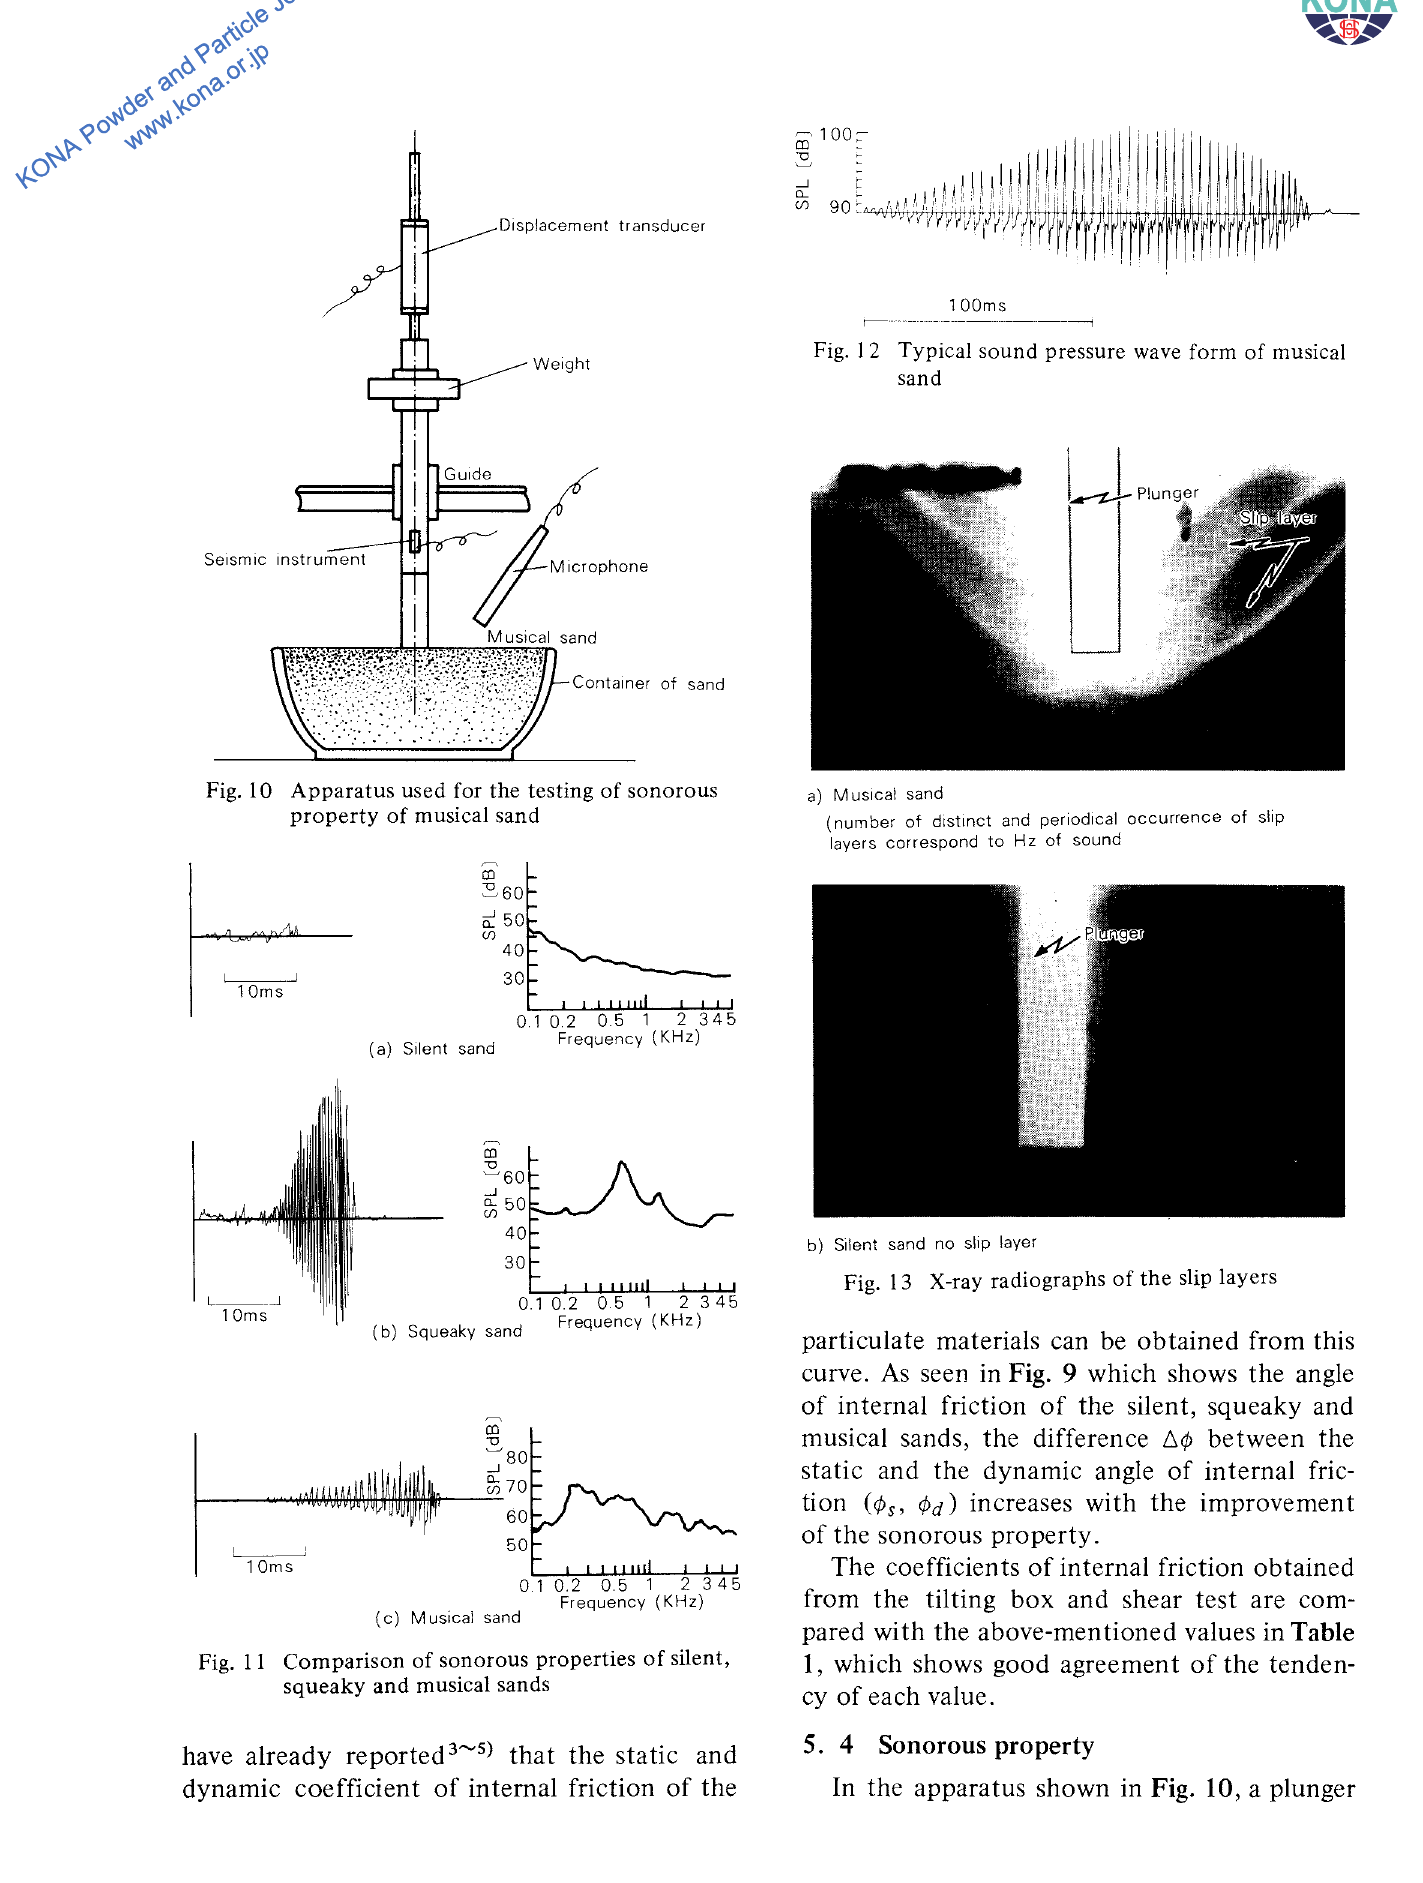
Fig. II Comparison of sonorous properties of silent, squeaky and musical sands